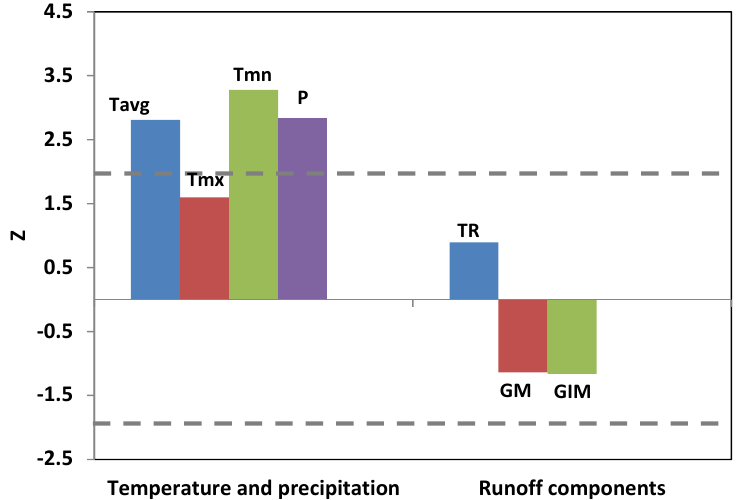
Figure 7. Z statistics for annual temperature, precipitation, runoff, glacier melt and ice melt from 1968 to 2007 in the Yarkant River basin. Tavg, Tmx and Tmn represent average, maximum and minimum temperatures, respectively. P represents precipitation. TR, GM and GIM represent total runoff, glacier melt and ice melt, respectively. The grey dotted lines represent the critical values of the normal distribution at the 5% confidence level (Z = ±1.96). Water 2016 , 8 , 186